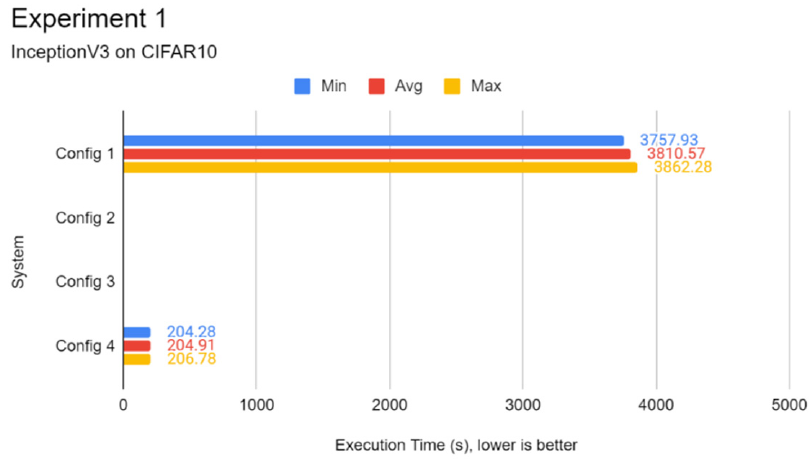
Figure A2. Bar chart execution time results for all systems running InceptionV3 on CIFAR10 in Experiment 1. Configurations 2 and 3 are excluded due to Spark OOM error.